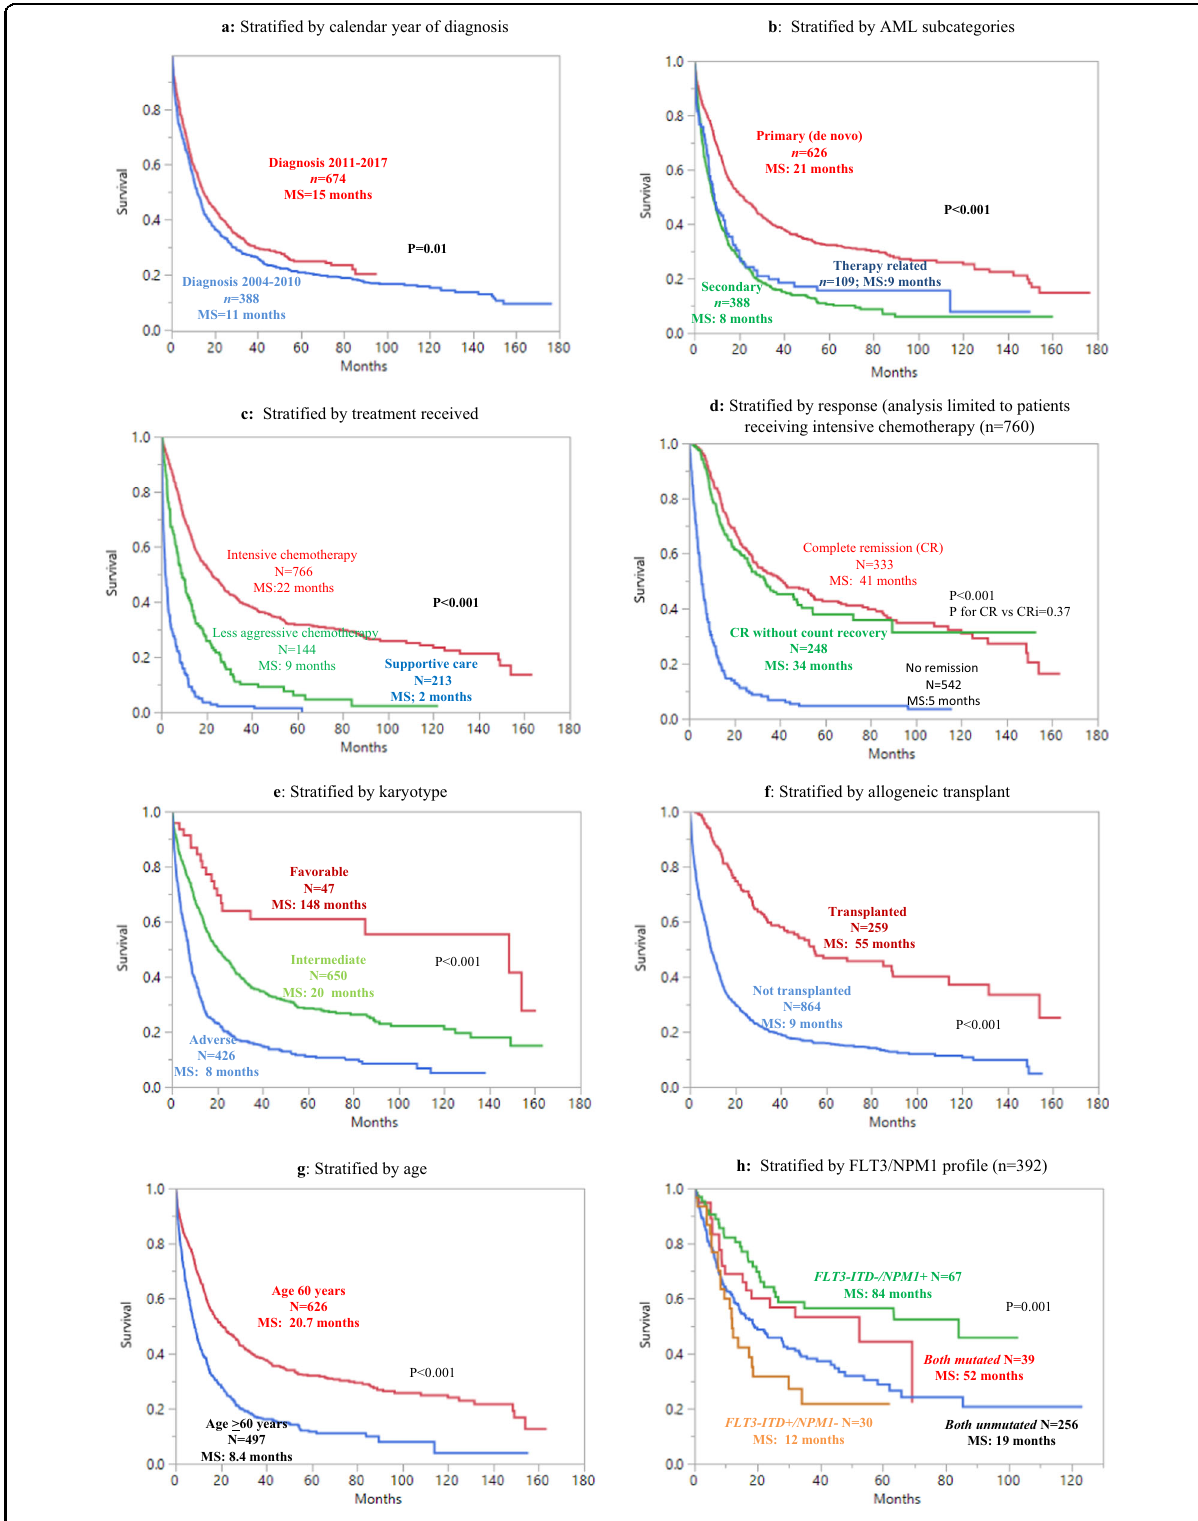
Fig. 1 Overall survival data among 1123 consecutive adults with non-APL acute myeloid leukemia (AML). a Analysis strati fi ed by calendar year of diagnosis. b Analysis strati fi ed by AML subcategories. c Analysis strati fi ed by treatment received. d Analysis strati fi ed by response obtained (limited to patients who received induction chemotherapy ( n = 760). MS median survival. e Overall survival data among 1123 consecutive adults with non-APL acute myeloid leukemia (AML) strati fi ed by karyotype. f Analysis strati fi ed by allogeneic stem cell transplant. g Analysis strati fi ed by age. h Analysis strati fi ed by FLT3-ITD/NPM1 mutational